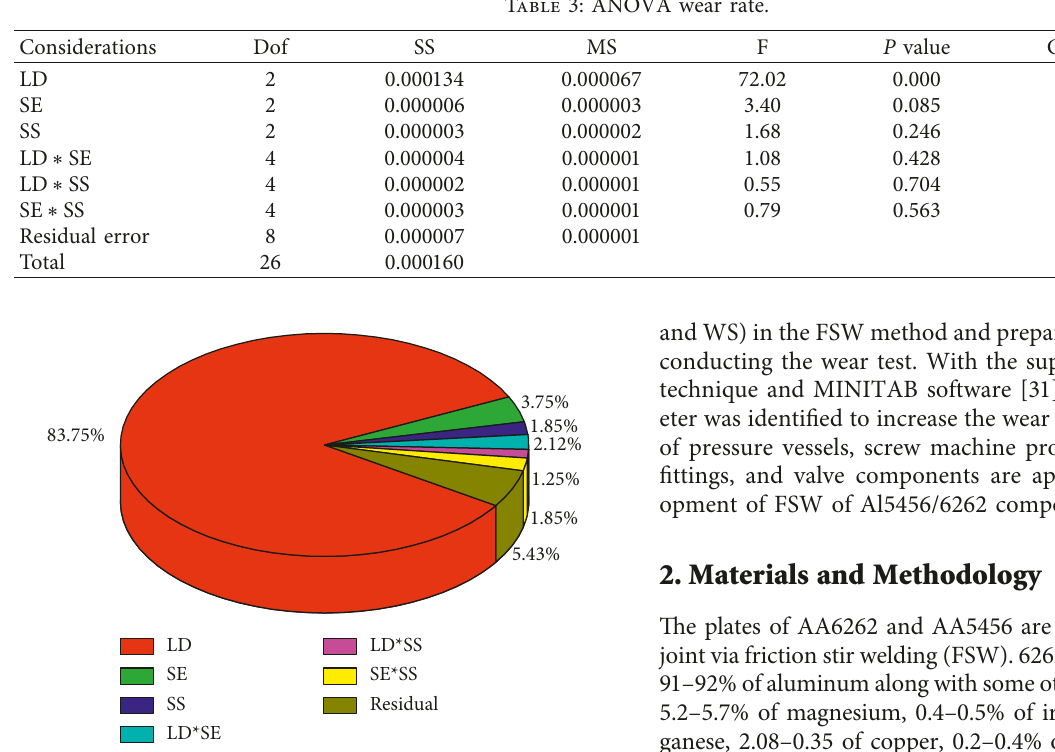
Figure 7: Contribution of WR parameters.